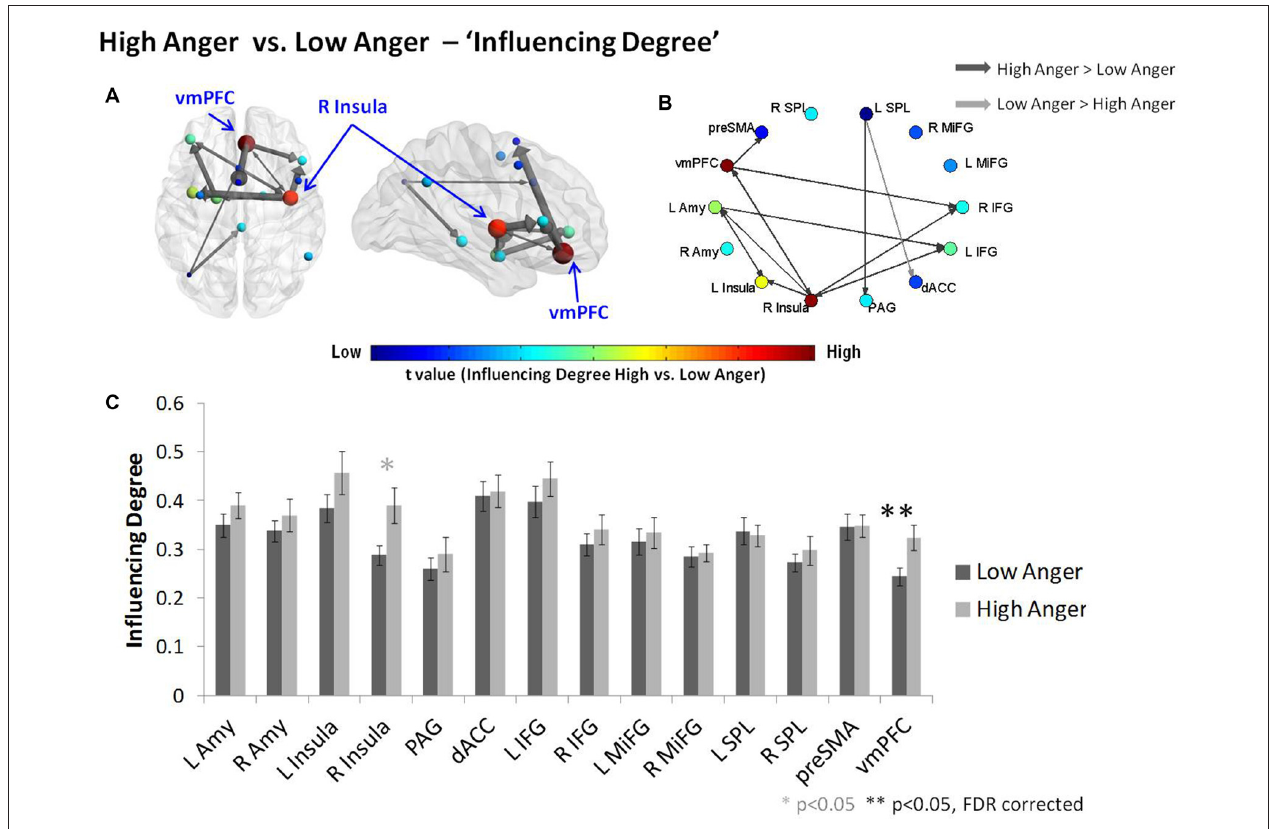
FIGURE 3 | Characterizing anger states by D EP NA “Influencing Degree”. The “Influencing Degree” network graph constructed for high anger minus low anger. The reactivity-regulation network illustrated on sagittal and axial views (A) and graphs visualization (B) . Each ROI was sized and color-coded according to its “Influencing Degree”. Warmer colors and bigger sphere represent a more influencing node. All pairwise ROIs with connections that were significant at the p < 0.05 level, using a t -test, are plotted as edges. The arrows indicate the direction of the influence, and the arrows’ size represents the t-statistic. (C) The nodes’ “Influencing Degree” averaged over all 74 subjects. The influence of the ventromedial prefrontal cortex (vmPFC) was significantly higher in the high anger condition vs. low